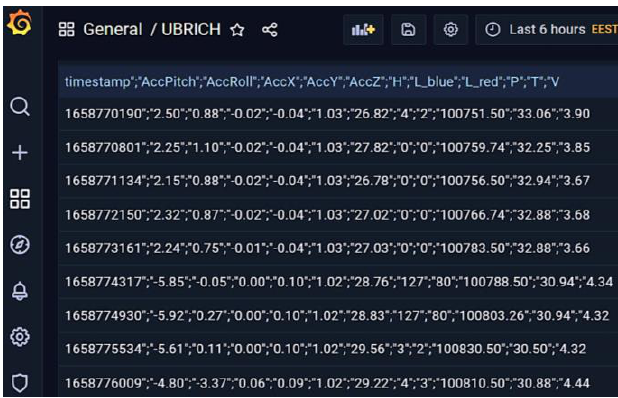
Figure 28. Enrolling NB-IoT device with authentication keys and corresponding backend services.